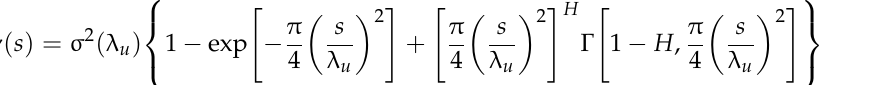
Figure 3a. The flow problem was numerically solved using MODFLOW based on the reference log hydraulic conductivity field, and 20 time steps were simulated for the flow problem. The reference flow field at the last simulation step corresponding to the reference Y field is depicted in Figure